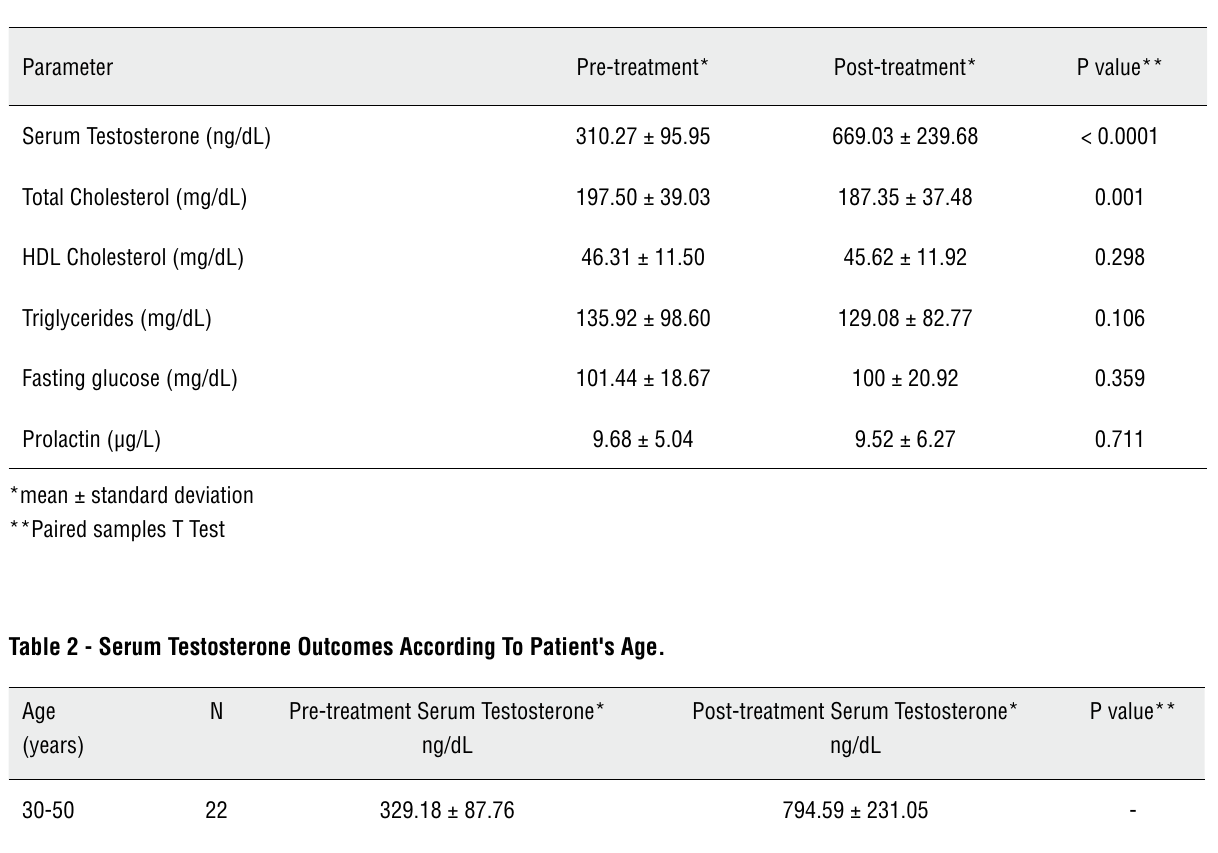
Table 1 - Hormonal and biochemical parameters pre and post treatment with clomiphene citrate, 25 mg/day, in 125 hypogo- nadal men.